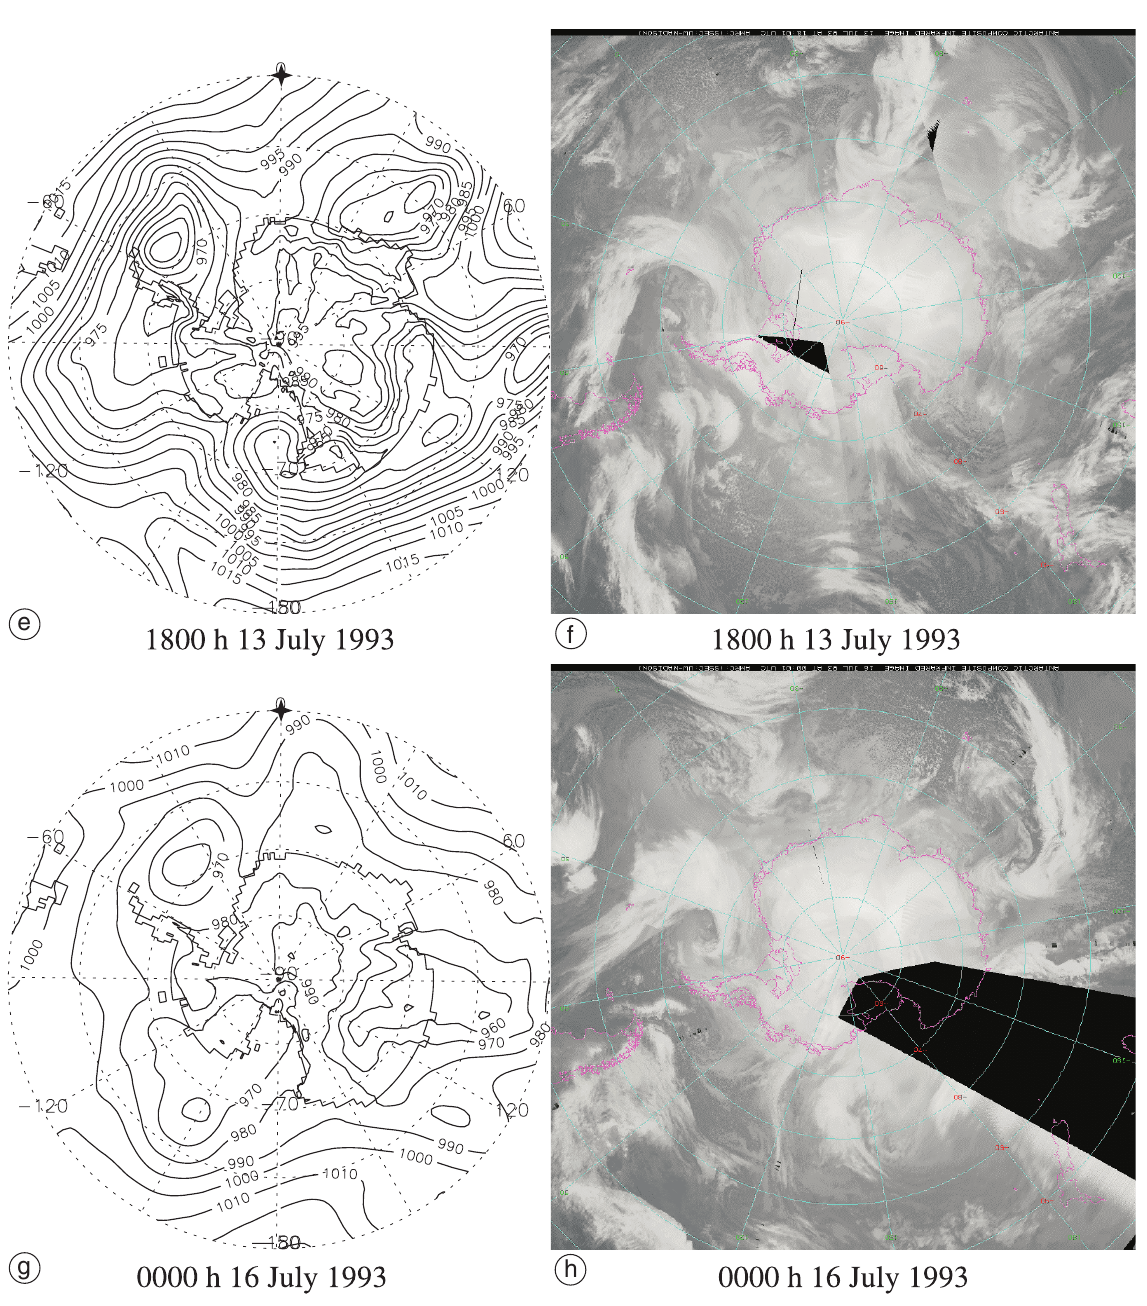
Fig. 7e-h. ECMWF analyses of mean sea level pressure charts and composite infrared satellite images for 1800 h 13 July (e,f) and 0000 h 16 July 1993 (g,h),